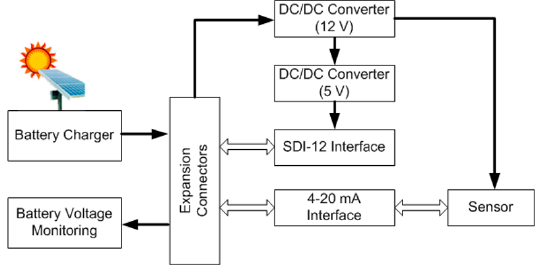
Figure 3. Block diagram of the sensor board.